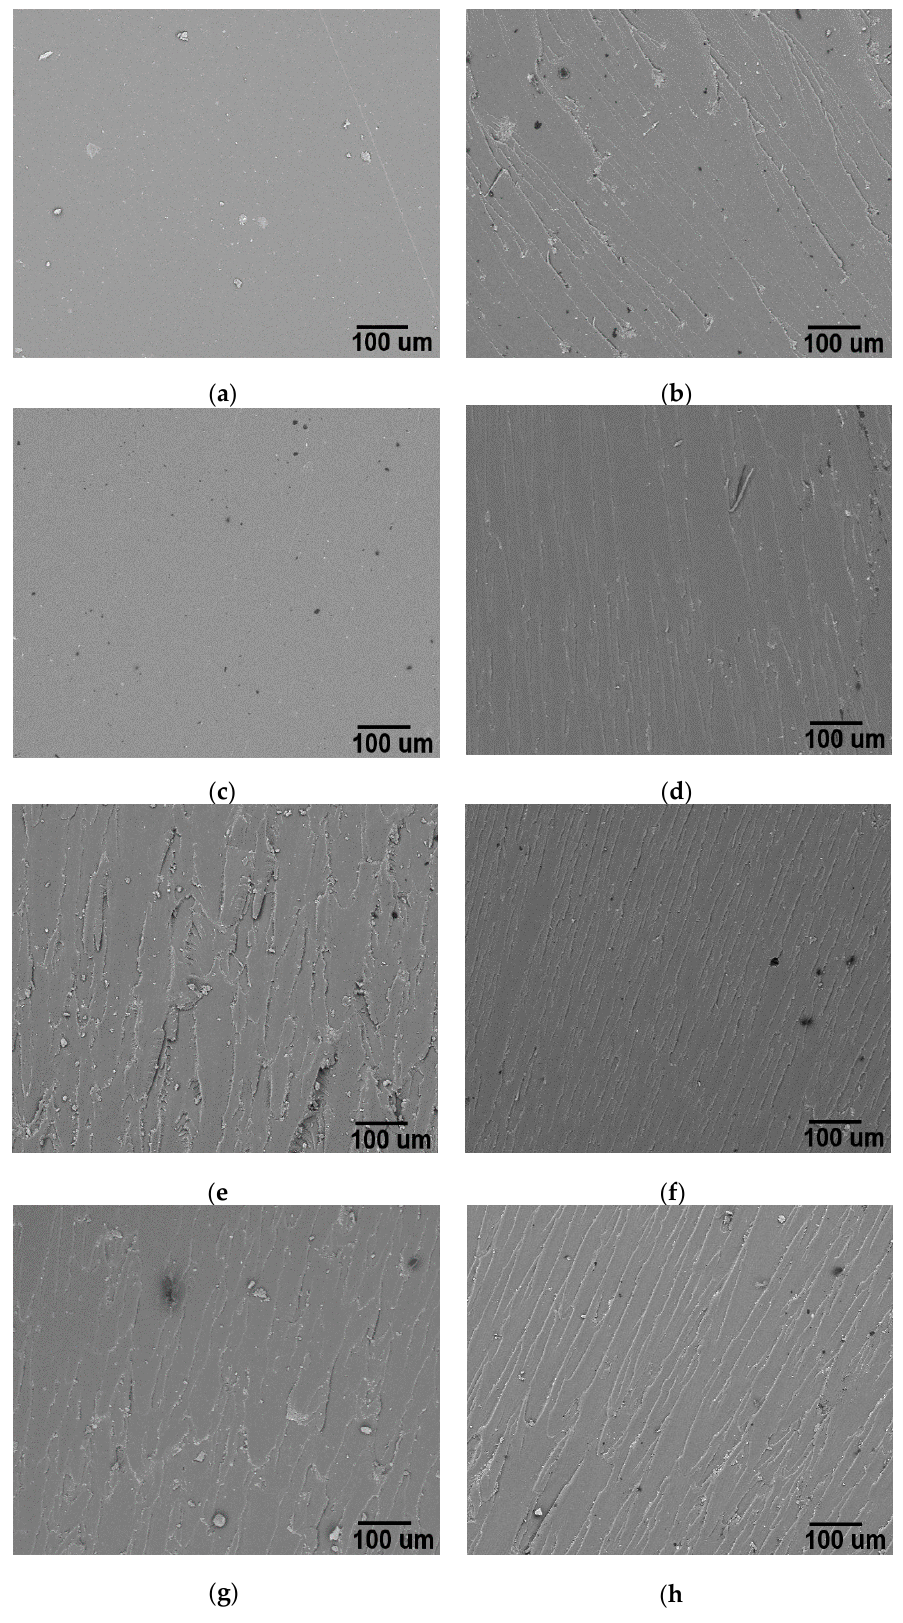
Figure 7. Micrograph of: ( a ) Neat epoxy MD ( b ) RGO 0.5 wt % MD; ( c ) MWCNT 0.1 wt % MD; ( d ) O-MWCNT 0.1 wt % MD; ( e ) RGO 0.1 wt % MD; ( f ) GO 0.1 wt % MD; ( g ) MWCNT-RGO 0.1–0.1 wt % MD; and ( h ) O-MWCNT-GO 0.1–0.1 wt % MD.